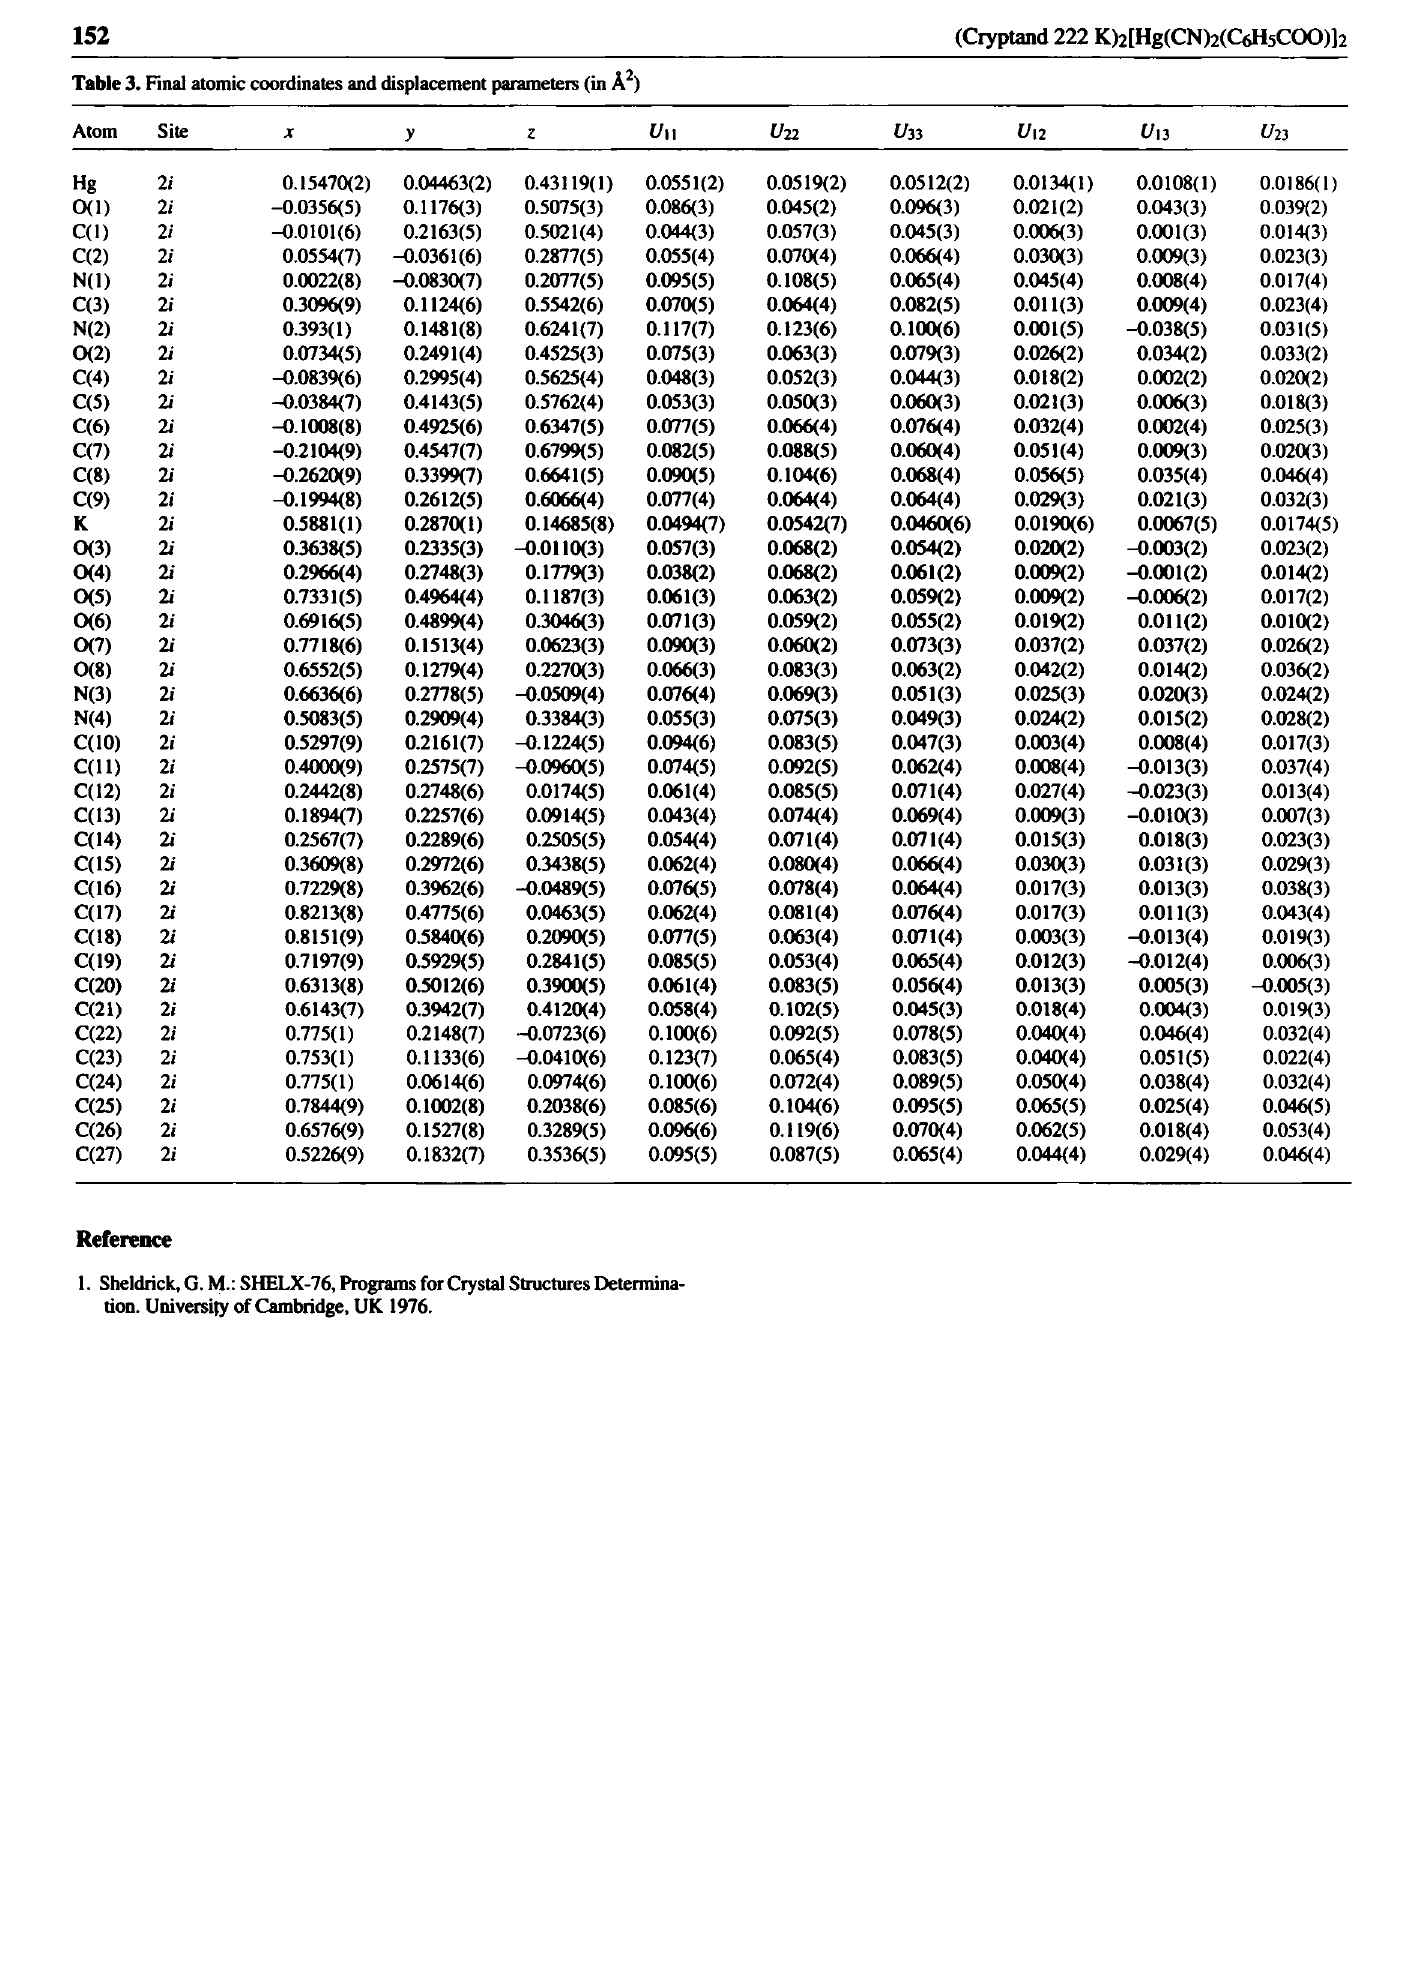
Table 3. Final atomic coordinates and displacement parameters (in Â 2 )